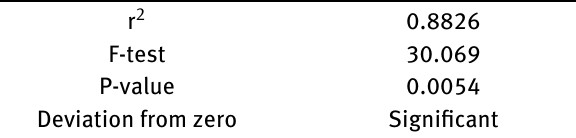
Figure 3: Dependence of postal item on revenues of domestic e- shops.